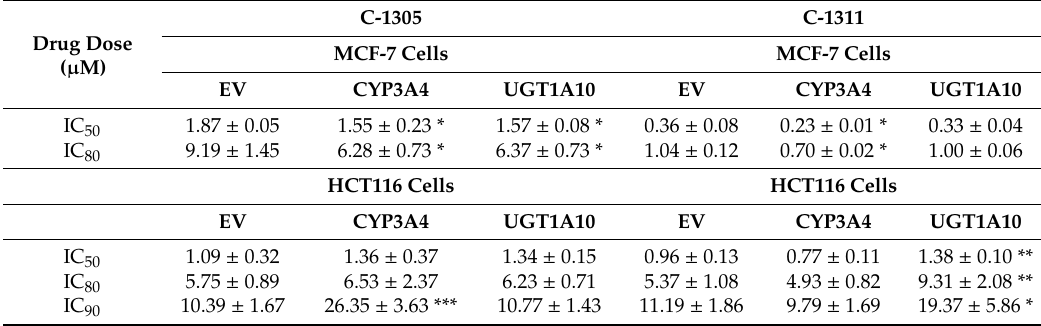
Table 2. Cytotoxicity of C-1305 and C-1311 against MCF-7 and HCT116 stably transfected with